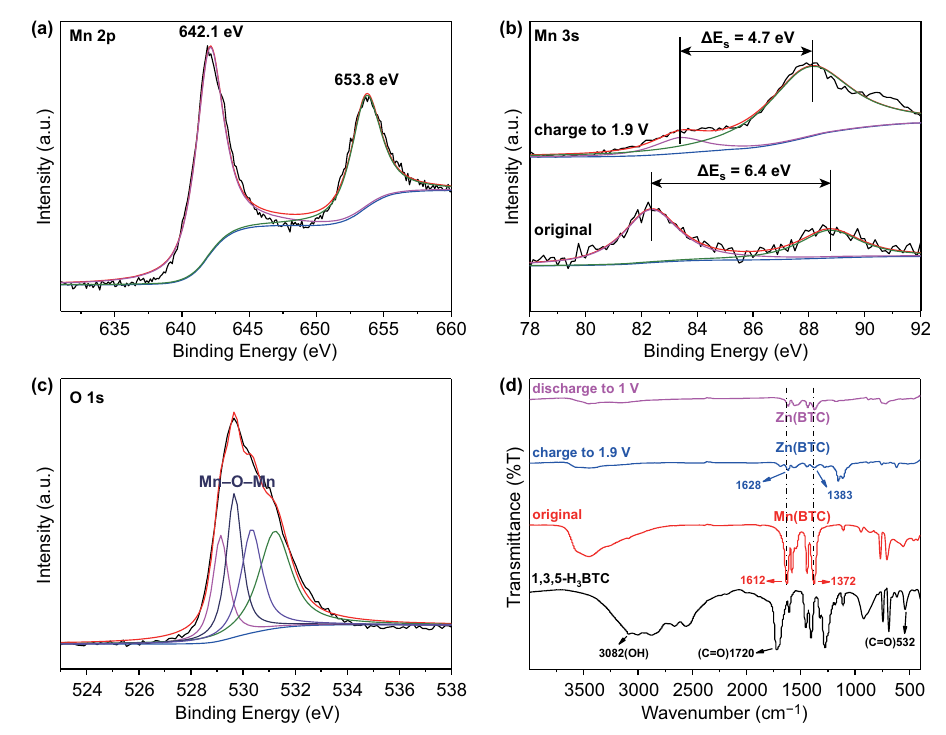
Fig. 4 XPS spectra of the Mn(BTC) cathode at fully charged state: a Mn 2 p , b Mn 3 s , and c O 1 s . Mn 3 s XPS spectrum of the original Mn(BTC) cathode is also presented in b . d FTIR spectra of 1,3,5‑H 3 BTC, original Mn(BTC) cathode, Mn(BTC) cathode at 1.9 and 1.0